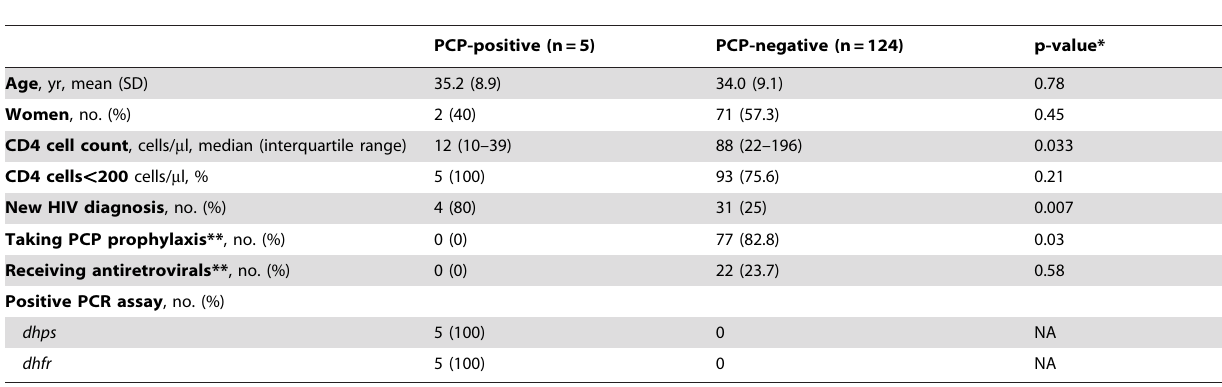
Table 2. Comparison of 129 consecutive HIV-infected patients with and without Pneumocystis pneumonia